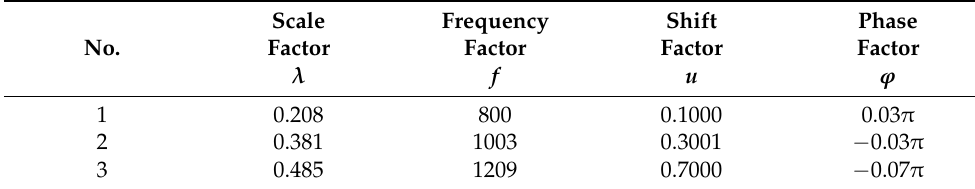
Table 6. Time–frequency factors of S 2 with the traditional method.